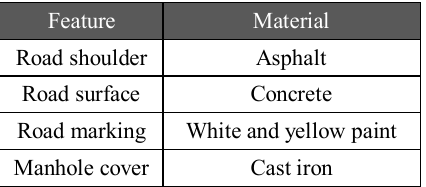
Table 1. Features of road surface